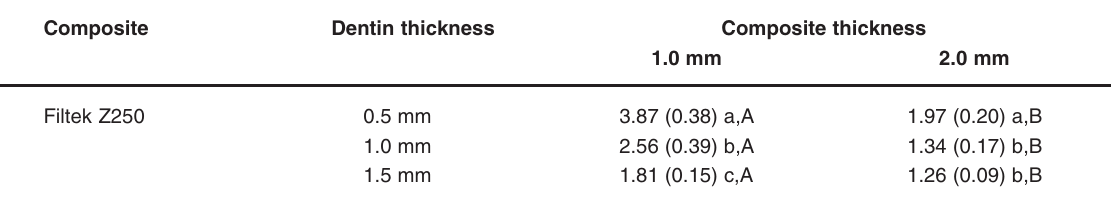
Different lowercase letters in columns and uppercase letters in rows indicate statistically significant difference (Tukey’s test, p<0.05). Standard deviations are given in parentheses. TABLE 4- Mean temperature increase ( 0 C) for the composite Filtek Z100 for each dentin and composite thickness